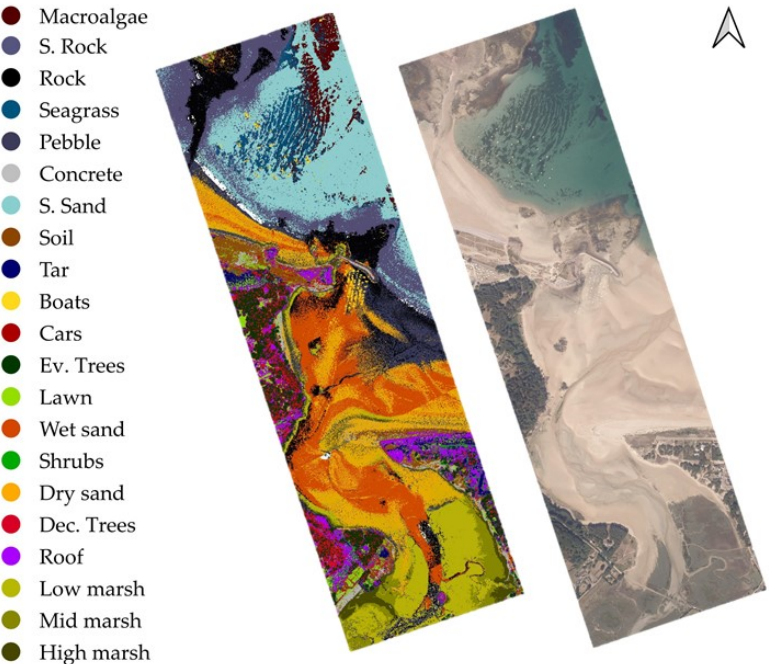
Figure A3. Projected 3D map of the habitats obtained with the predictions of a random forest classifier on green spectral features and elevation values; orthoimage of the study area. The orthoimage was captured in 2014, while lidar data are not contemporaneous as they date from 2019. S. = submerged, Ev. = evergreen, Dec. = deciduous.